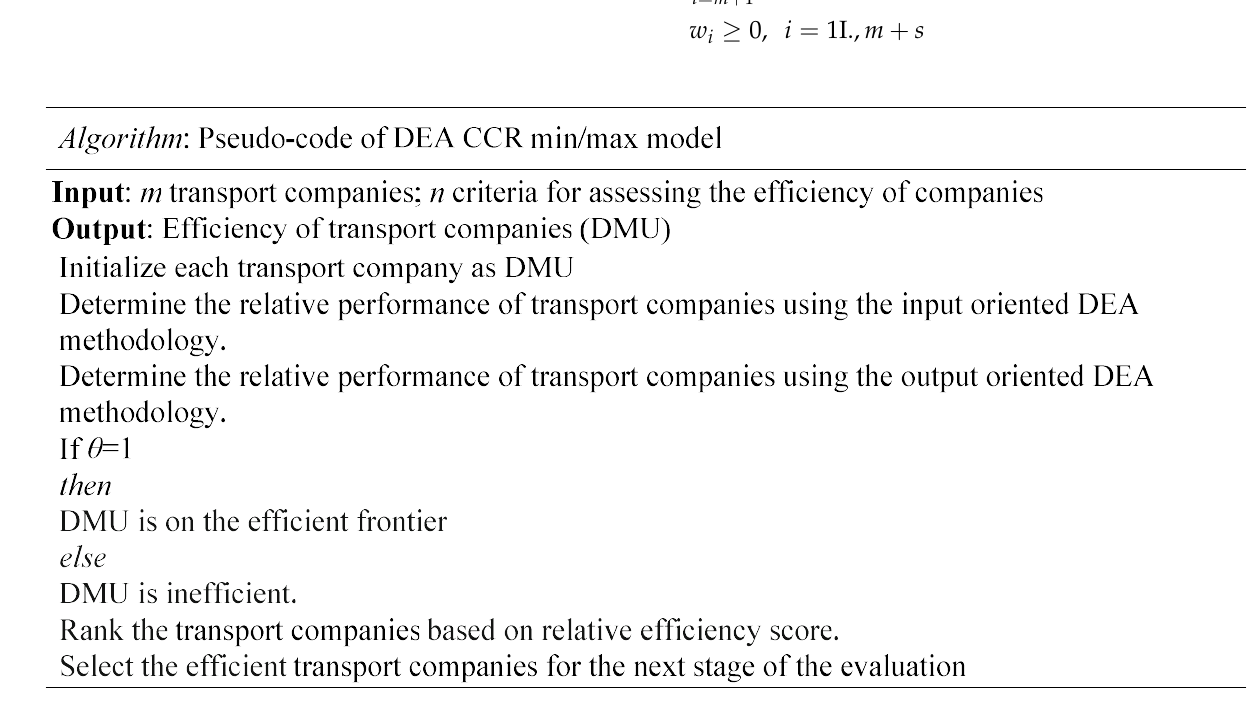
Figure 2. Pseudo-code for DEA model.